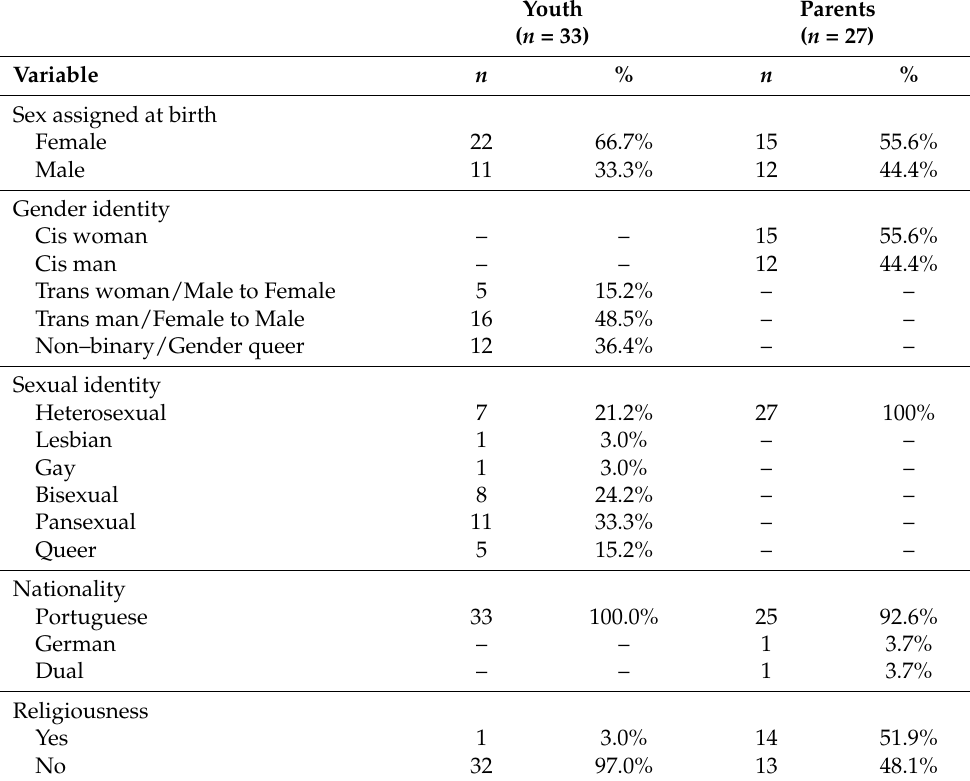
Table 1. Sociodemographic characteristics of the